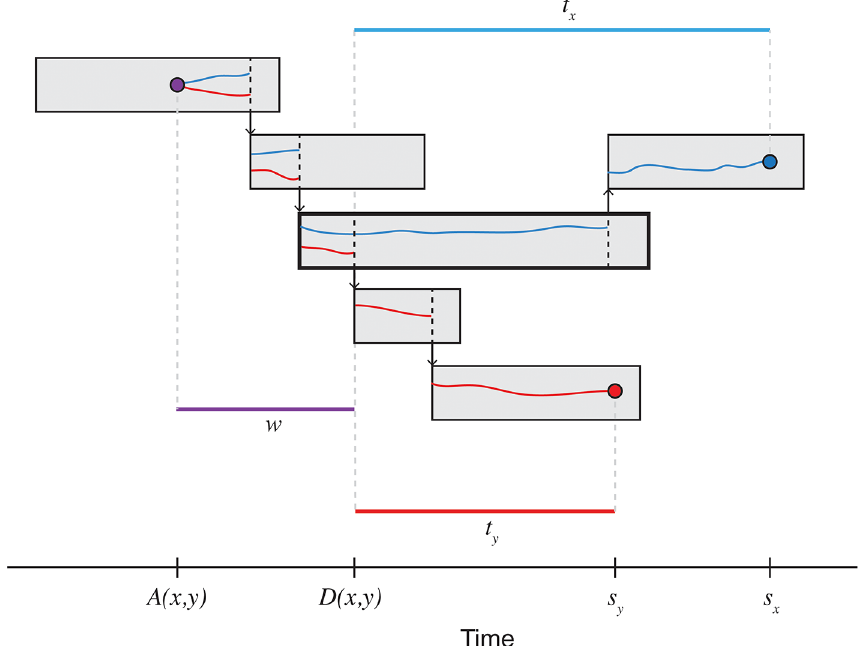
Fig 2. Disease transmission and pathogen lineages. Each rectangle represents an infected host over time, from infection to recovery, while arrows indicate transmission. Two pathogen isolates, marked as blue and red circles, are sampled at times s x and s y , and share a most recent common ancestor A ( x , y ), marked as a purple circle. Lineages diverge at time D ( x , y ), after which they exist independently in different hosts. With a transmission bottleneck of size 1, the most recent common ancestor must be found within the host highlighted in bold, however in general, multiple lineages may be passed between hosts. The time from coalescence to lineage divergence, w , is exponentially distributed, assuming a constant effective population size. The number of mutations arising during this unknown period follows a geometric distribution, while the total occurring after lineage divergence D ( x , y ) follows a Poisson